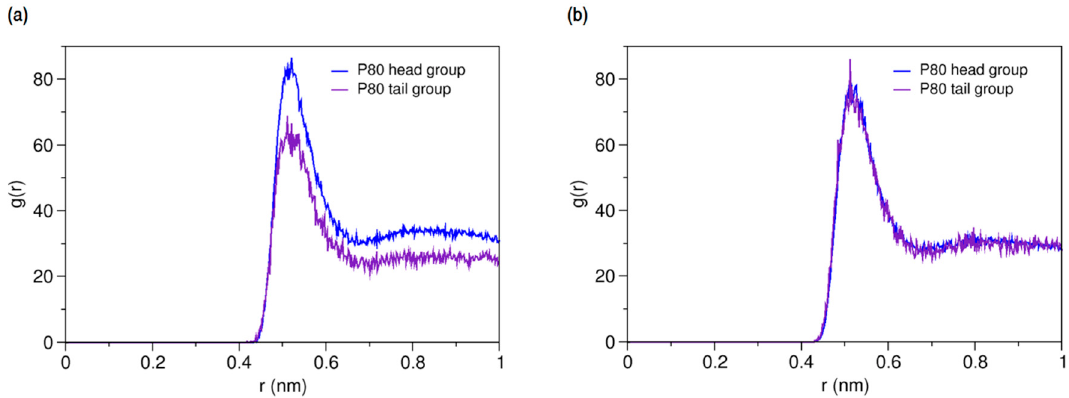
Figure 7. Average radial pair distribution functions for head and tail of P80 against ( a ) AmB; and ( b ) Nys in aqueous medium.